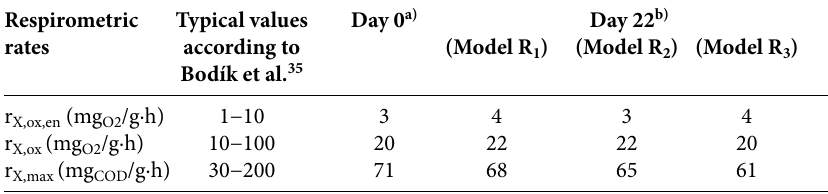
Table 4. Results of respirometric measurements.